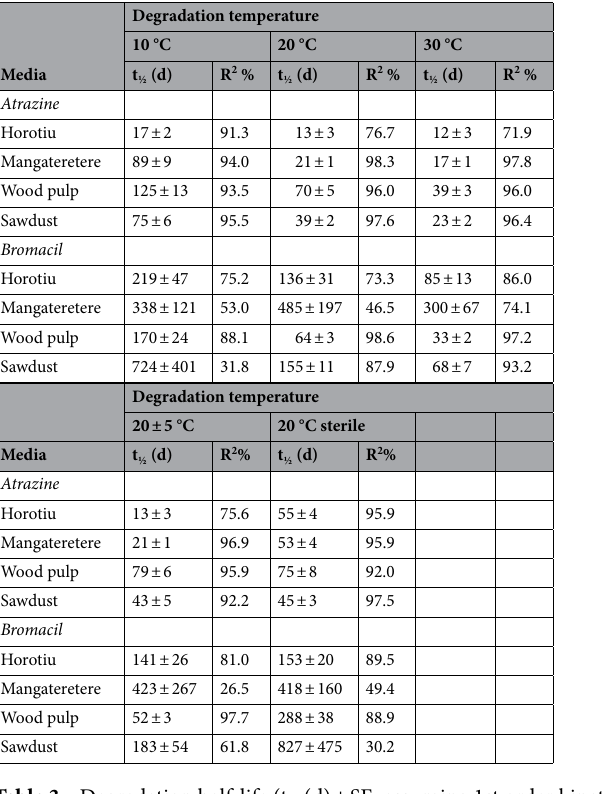
Table 3. Degradation half-life (t ½ (d) ± SE, assuming 1st order kinetics) and R 2 linear regression statistic for degradation of atrazine and bromacil in four media under five different degradation regimes.